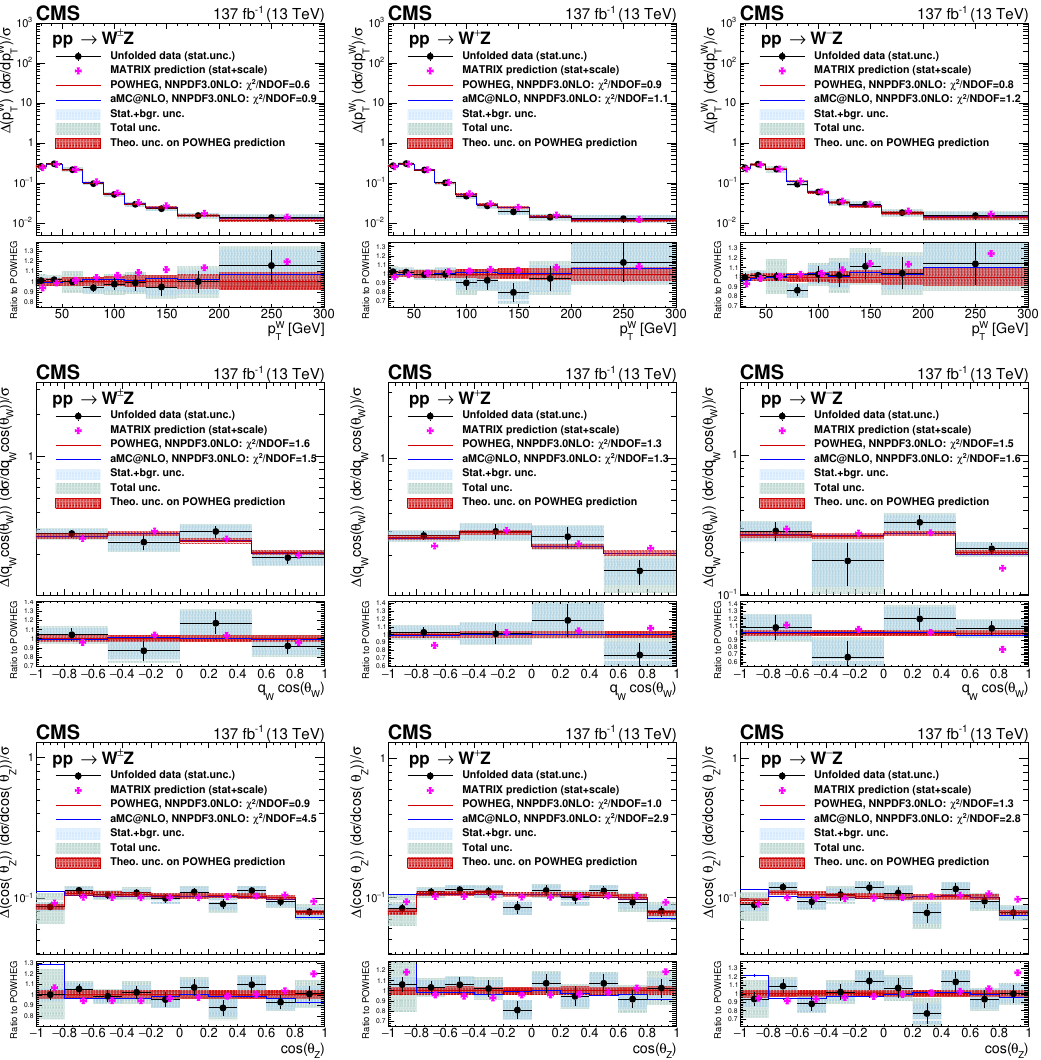
Figure 16 . Unfolded results for several variables and charged final states. From top to bottom: of the lepton in the W boson decay, cosine of the polarization angle of the W boson times total p T leptonic charge, and cosine of the polarization angle of the Z boson. From left to right: charge- inclusive, positive-charge, and negative-charge final states. Black dots represent unfolded data results, black vertical bars denote statistical uncertainties in the unfolded data results, shaded blue bands represent statistical plus background-related uncertainties, and the green band represent the total unfolding uncertainty. The red histogram and shadow bands are the powheg prediction and its theoretical uncertainty. The blue histogram represents the MadGraph 5_a mc@nlo prediction and the violet points show the matrix prediction including error bands representing numerical and scale uncertainties. The matrix predictions are represented by points with a small offset to the right to improve